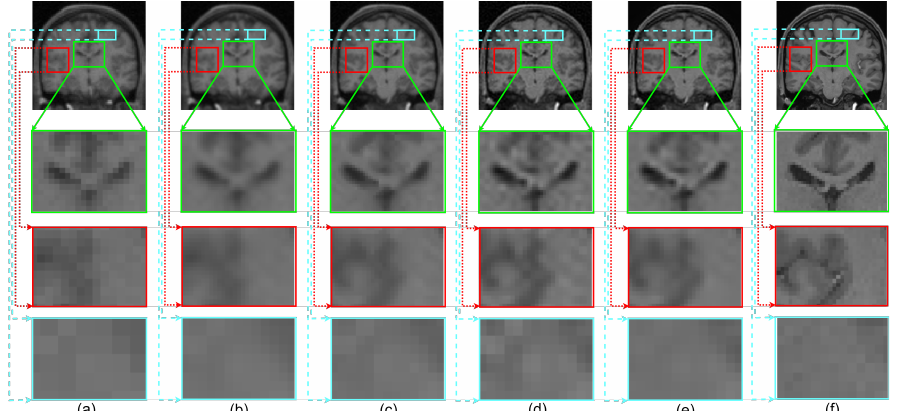
Figure 13. Demonstration of reconstruction quality of different kinds of regions/patches, region with edges (green boxes), region with texture (red boxes), and smooth region (cyan boxes), after super resolving real MR images degraded with downsampling factor 2 and 2% noise, using different algorithms. ( a ) NN interpolation of noisy LR image, ( b ) spline interpolation of denoised LR image, the proposed work applied on a noisy LR image, and ( f ) the original noise-free HR